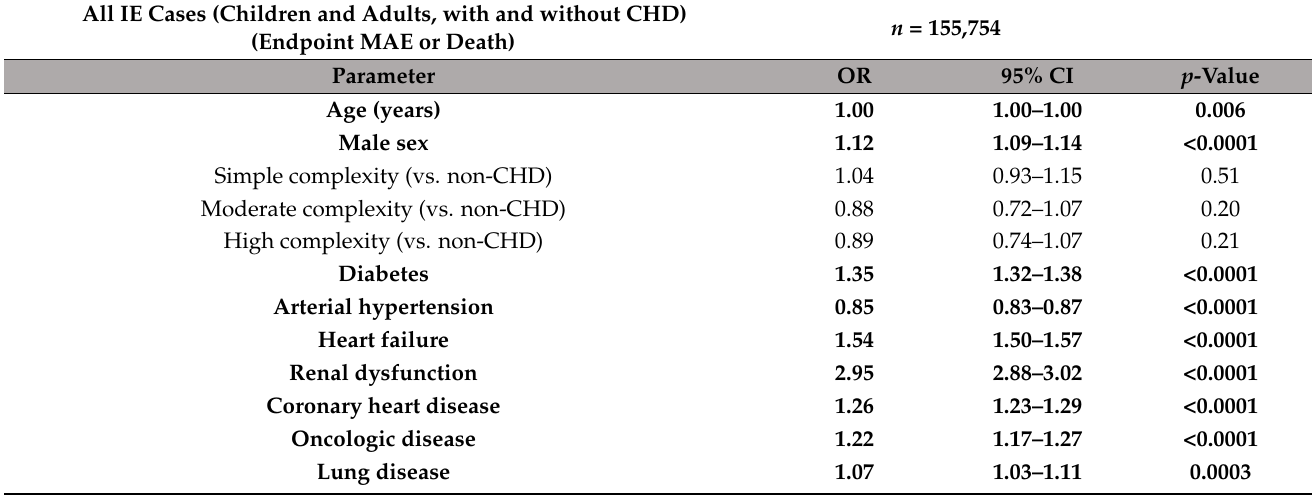
Table 6. Association between age, sex, disease complexity and co-morbidities, and major adverse events or death in all patients with infective endocarditis. IE = infective endocarditis; CHD = congenital heart disease; MAE = major adverse events; CI = confidence interval; OR = odds ratio. Significant variables are in bold. All IE Cases (Children and Adults, with and without CHD)